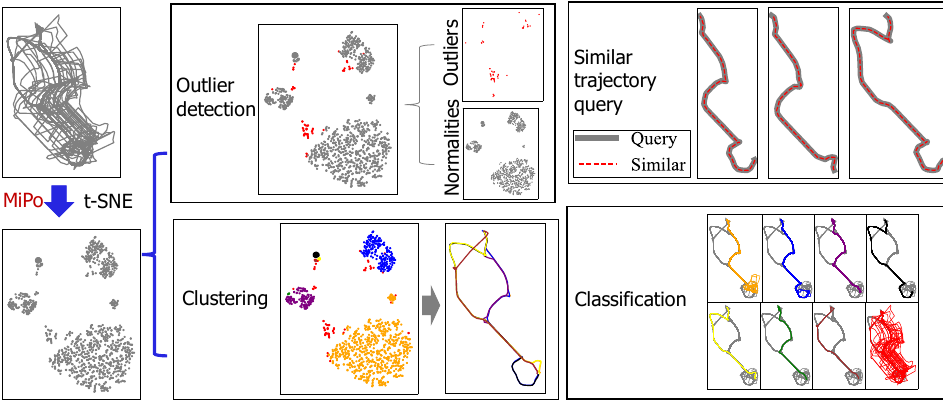
Figure 13. Examples of the potential applications of MiPo with the AiSq5D